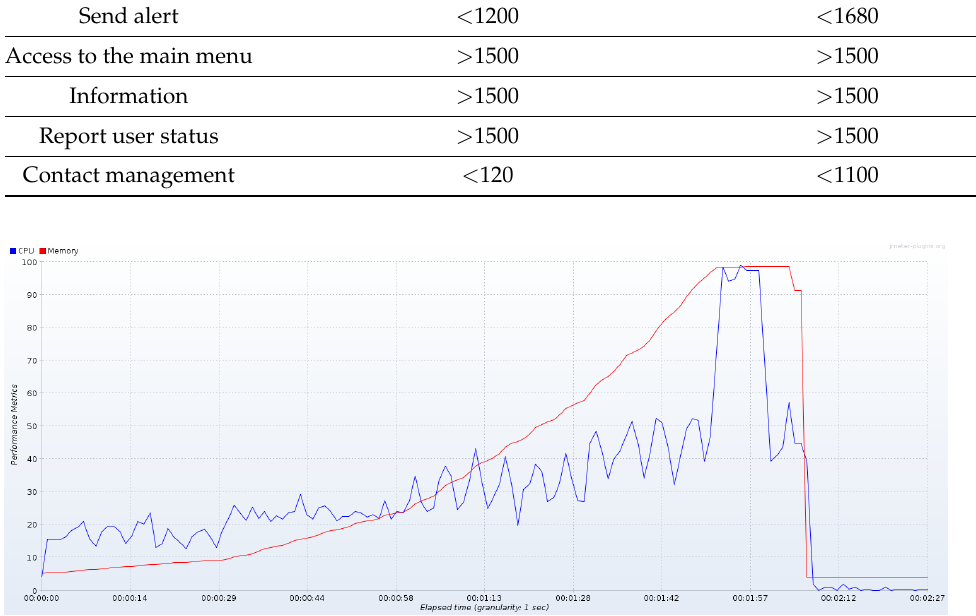
Figure 16. Single processor: CPU and RAM memory utilization reported by the “Send alert” task.